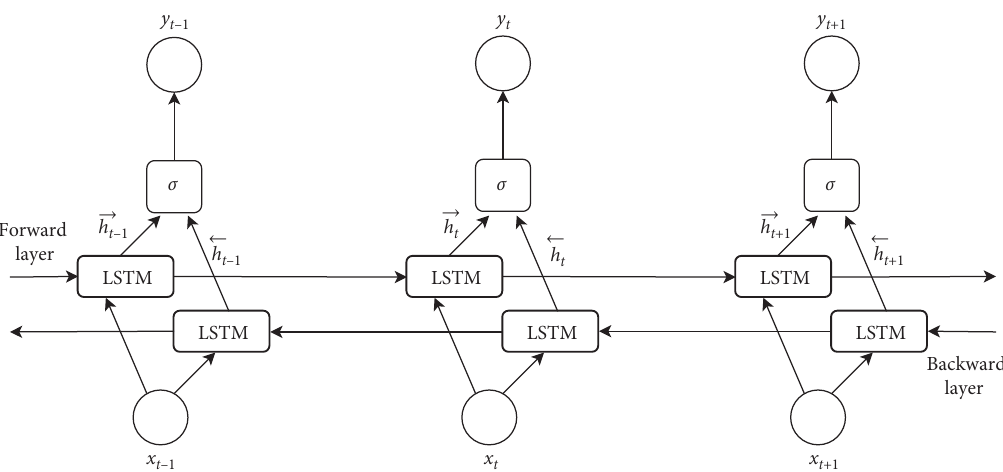
→ ← : hidden state for the positive direction; h : hidden